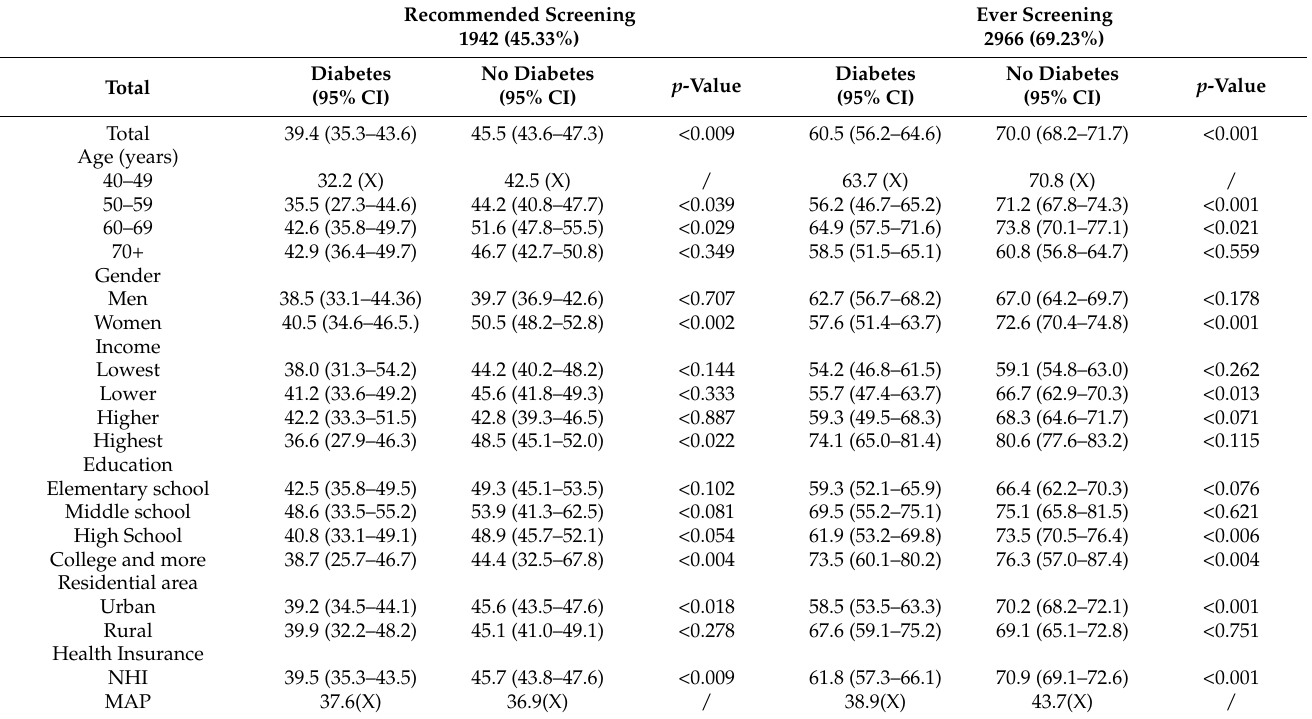
Table 2. Ever and recommended gastric cancer screening rates in diabetes and non-diabetes